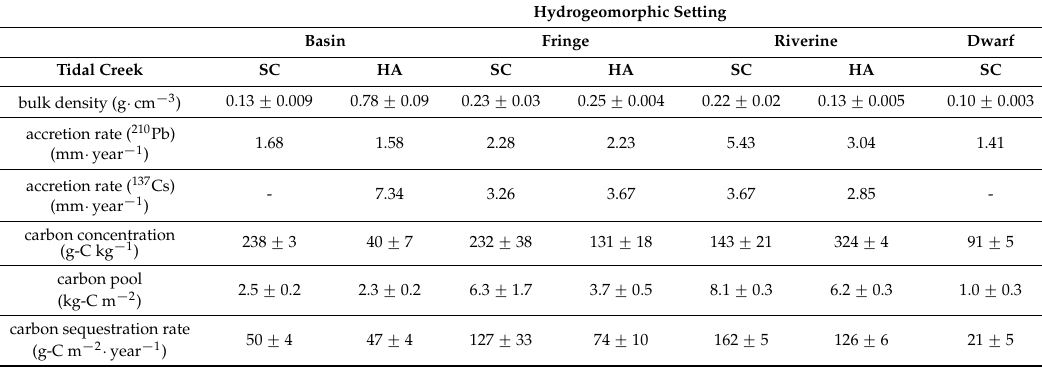
Figure 3. Soil carbon concentration (g-C kg ´ 1 ) in different mangrove landscapes for hydrologically disturbed Hamilton Avenue Creek (HA) and reference Susan’s Creek (SC). Table 2. Soil bulk density (past 50 years), sediment accretion rates (two methods), carbon concentration, carbon pool, and carbon sequestration rates at mangrove study sites at Susan’s Creek (SC; reference) and Hamilton Avenue Creek (HA; disturbed), adjacent to Naples